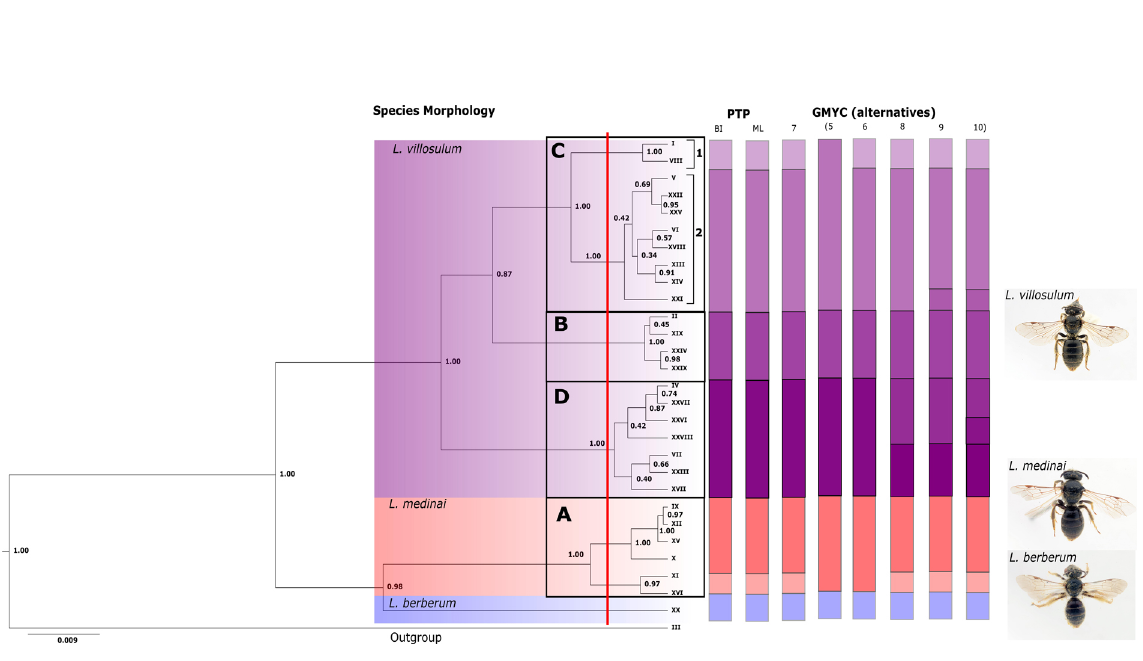
Fig. 4. Ultrametric tree constructed using Bayesian inference and based on 29 haplotype sequences (658bp) of the cytochrome oxidase c subunit I gene of specimens currently identified as Lasioglossum villosulum (Kirby, 1802) , Lasioglossum medinai (Vachal, 1895) and one as Lasioglossum berberum (Benoist, 1941). Each label corresponds to one roman letter which encompasses all sequence from a haplotype (for more details see Table 3). A . Lasioglossum medinai ; B–D: three supported clusters (a fourth cluster could be defined in C) within Lasioglossum villosulum . This phylogenetic tree is rooted using Lasioglossum bluethgeni Ebmer, 1971 as outgroup (label III, voucher AP222). Posterior probabilities are given at nodes. The three colour gradients on the tree correspond to morphological delineation. Results of the species delimitations analyses are represented on the right side of the figure: the Bayesian Poisson Tree Process (bPTP) analyses based on the trees obtained using Bayesian inference (BI) or maximum likelihood (ML); The Generalized Mixed Yule Coalescent (GMYC) analysis resulting in seven candidate species (using the single threshold represented as a red line on the tree) and five alternative scenarios. Numbers at the top of the columns corresponds to the number of candidate species in the GMYC